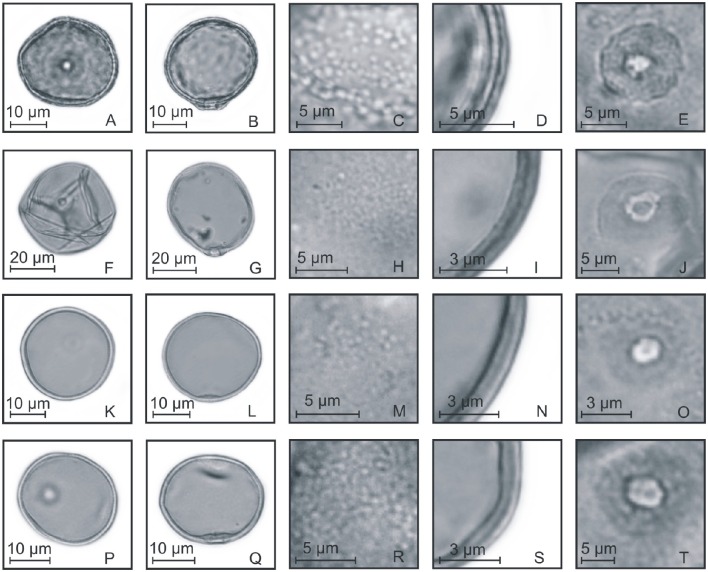
Pollen grains of the subfamilies Anomochlooideae, Bambusoideae, and Pharoideae. (A–E)
Streptochaeta spicata: PV (A), EV (B), detail of ornamentation (C), detail of the thickness of the exine (D), and detail of the aperture (E); (F–J)
Chusquea juergensii: PV (F), EV (G), detail of ornamentation (H), detail of the thickness of the exine (I), and detail of the aperture (J); (K–O)
Olyra latifolia: PV (K), EV (L), detail of ornamentation (M), detail of the thickness of the exine (N), and detail of the aperture (O); (P–T)
Pharus lappulaceus: PV (P), EV (Q), detail of ornamentation (R), detail of the thickness of the exine (S), and detail of the aperture (T).